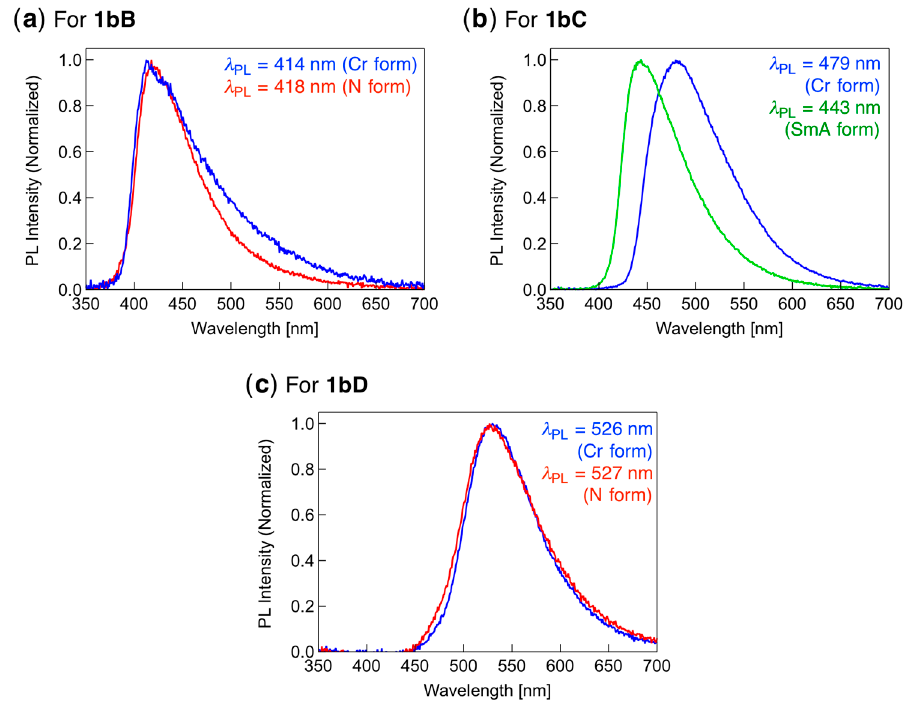
Figure 8. PL spectra of the Cr and LC phases of ( a ) 1bB , ( b ) 1bC , and ( c ) 1bD upon excitation at 320 nm.